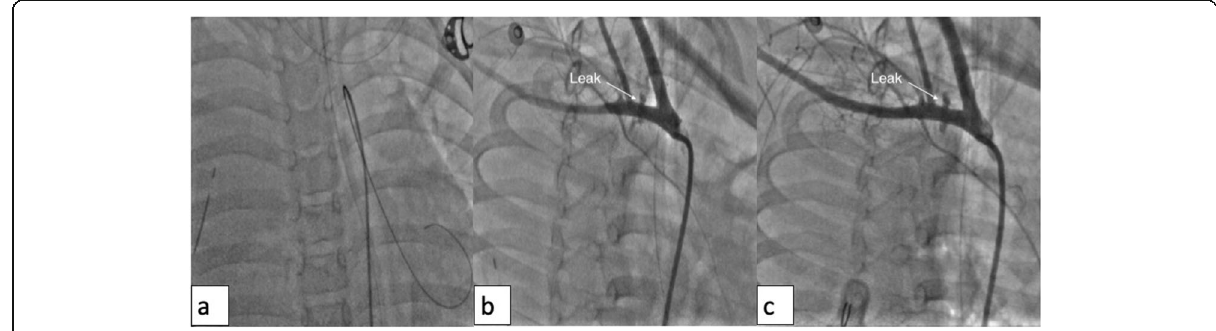
Fig. 1 a Mediastinal shift to the left with massive right hemothorax. b Selective right SCA injection (RAO) showing perforation in the first part, between right CCA, and right vertebral artery. c Post ICD revision, selective right SCA injection showing more prominent dye leak s/o significant perforation in the first part, between right CCA, and right vertebral